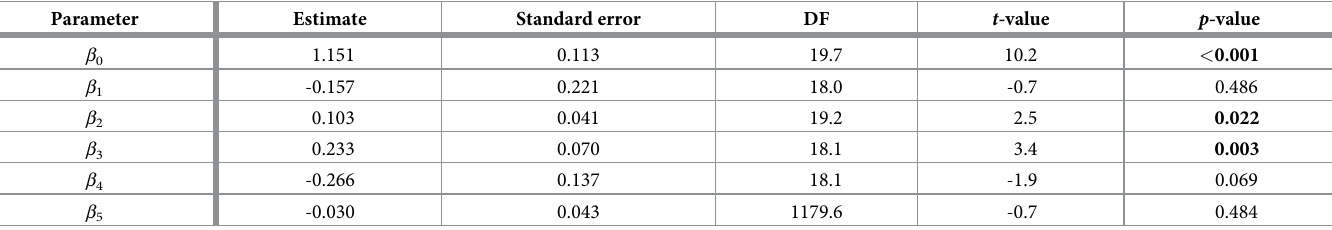
Table 1. Estimated fixed-effects parameters. The parameters were determined by fitting the linear mixed-effects model in Eq 1 to the data in Fig 3 and are given in terms of the estimate and the standard error on the logarithmic scale, the degrees of freedom (DF), the t -value, and the p -value, where p -values below a significance level of 5% are written in